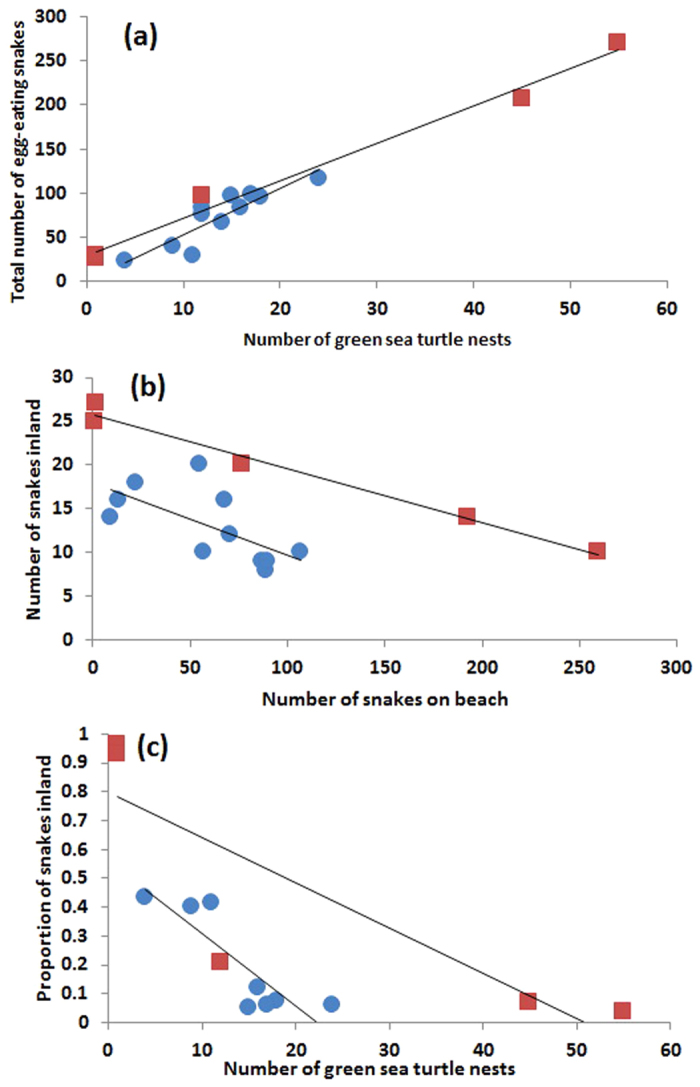
Relationships between sea turtle nesting and egg-eating snake abundance on Orchid Island, Taiwan.Egg-eating snake abundance depends upon sea turtle nest availability (a). When more egg-eating snakes are at the sea turtle nesting beach, fewer are found inland (b). Ultimately, there is a negative relationship between sea turtle nest availability and the proportion of snakes inland (c). Circles show annual values (n = 11) and squares show monthly values (n = 5).